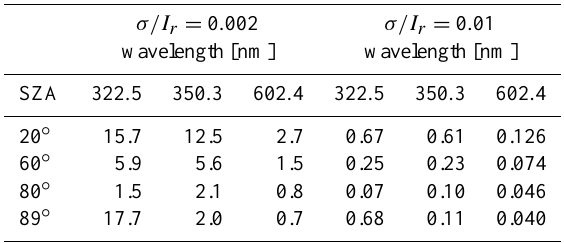
Table 1. Seconds for MC to estimate the observed radiance for 3 wavelengths [nm] at 4 tangent point solar zenith angles (SZA) and 2 precisions ( σ/I r